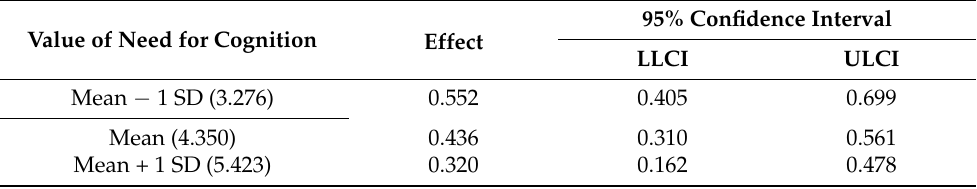
Table 3. Conditional effect of technology quality on empathy at value of need for cognition.